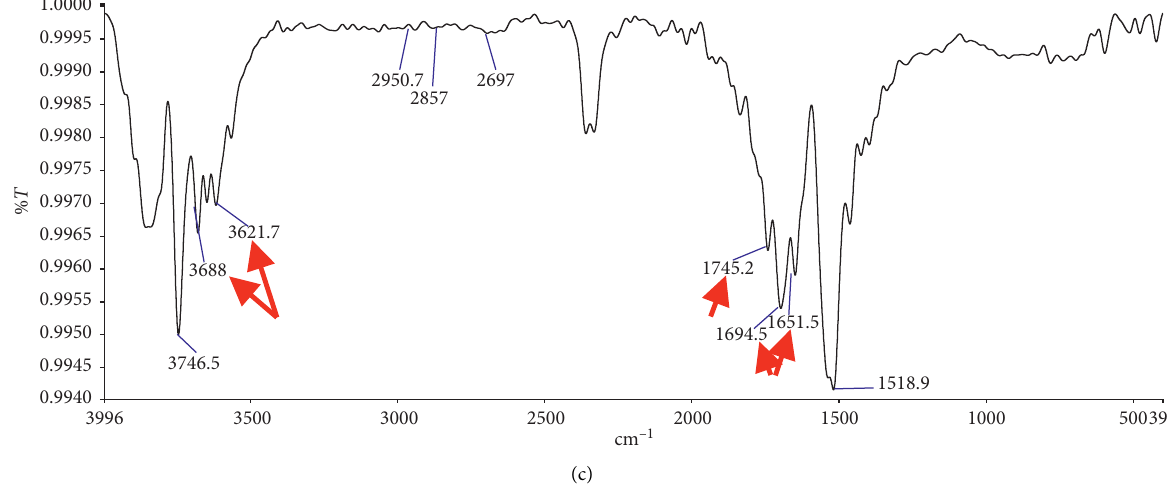
Figure 1: Fourier transform infrared spectroscopy of (a) light-polymerized, (b) Ivomate autopolymerized, and (c) microwave heat-po- lymerized samples.